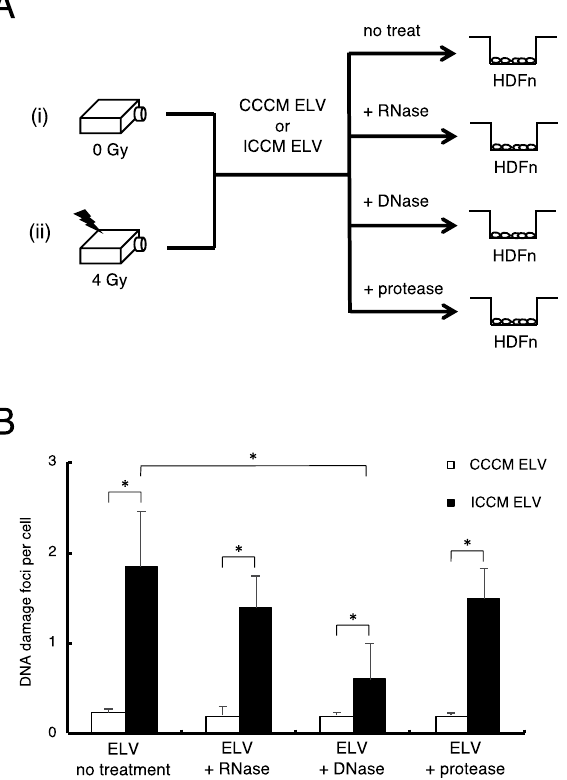
Figure 3. Effect of ICCM treated with RNases, DNases, and proteases on CCCM ELV and ICCM ELV. ( A ) A schematic view of the experimental protocol. ( B ) The frequency of DNA damage foci in cells treated with CCCM ELV and ICCM ELV (un-treated), cells treated with RNase exposed CCCM ELV and ICCM ELV ( + RNase), cells treated with DNase exposed CCCM ELV and ICCM ELV ( + DNase), and cells treated with protease exposed CCCM ELV or ICCM ELV ( + protease). Values are represented as mean ± standard error, with significant differences between indicated groups ( * ) calculated by Chi-square test ( p <